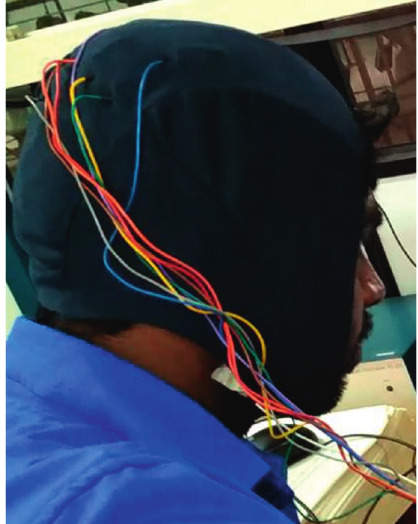
Figure 3: Physical view of the electrode